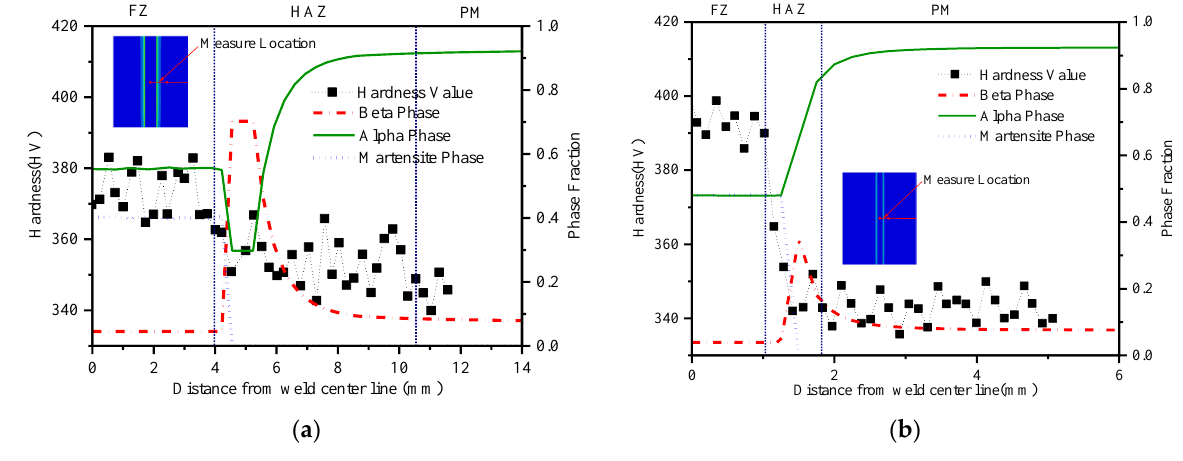
Figure 23. Micro-hardness distribution: ( a ) TIG weldment, ( b ) LBW weldment. The Vickers hardness relationship of the weld area is FZ > HAZ > PM. The hardness value of the FZ of the LBW weldment is about 54.57 HV higher than that of the PM. There is a narrow HAZ area of about 0.75 mm between the FZ and PM of the LBW weldment, which has a very large hardness gradient of 72.76 HV/mm. For TIG weldments, the HAZ area is wider, and the gradient of hardness reduction from the FZ to PM is about 3.66 HV/mm, which is much smaller than that of the LBW-welded